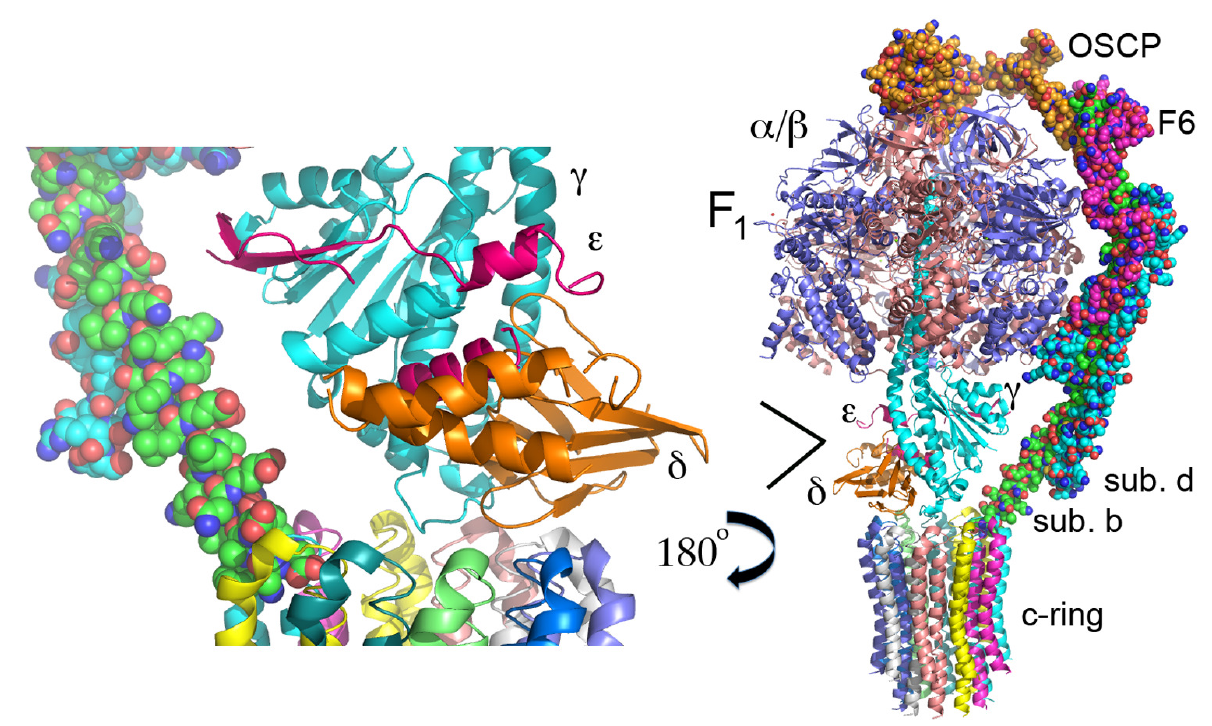
FIGURE 1: Structural representation of the ATP synthase. A composite representation of the ATP synthase is shown on the right with the F 1 , subunits of the stator, and the c 10 -ring shown. The structure of the F 1 and c 10 -ring were derived from the x-ray crystal structures (2HDL and 3U2F) while the structures of the stator (peripheral stalk) were derived from the x-ray crystal structures of the bovine components (2WSS and 2CLY). Note, that a number of subunits have not been represented in the structure, most notably, subunit-a, which forms the proton